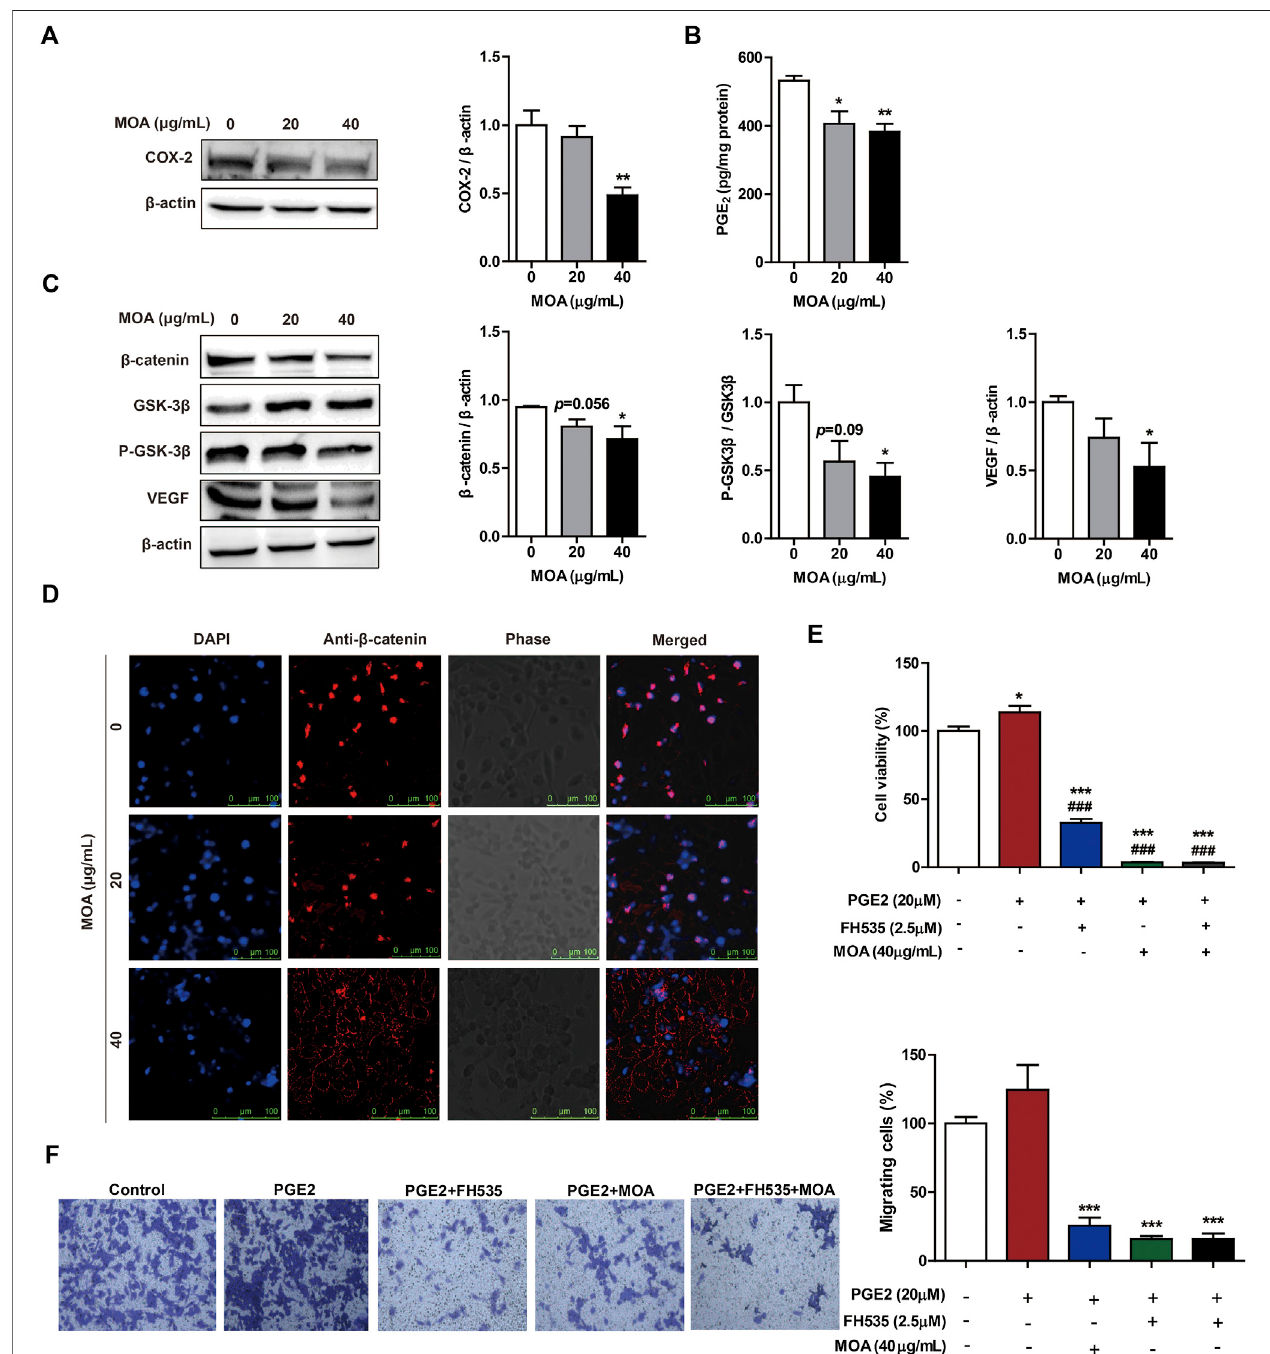
FIGURE4 | TreatmentwithMOAinhibitedPC3cellproliferationandmigrationviatheCOX-2mediatedWnt/ β -cateninsignalingpathway.Westernblottingwasusedto examine the protein levelsof COX-2 (A) , β -catenin, GSK-3 β , P-GSK-3 β , and VEGF (C) in PC3 cells treated with MOA (0, 20, and 40 μ g/ml) for 48 h. (B) The levelsof PGE 2 were measured in cell lysates using a PGE 2 immunoassay kit. (D) Subcellular localization of β -catenin protein was determined using immuno fl uorescence. (E,F) Cell viability